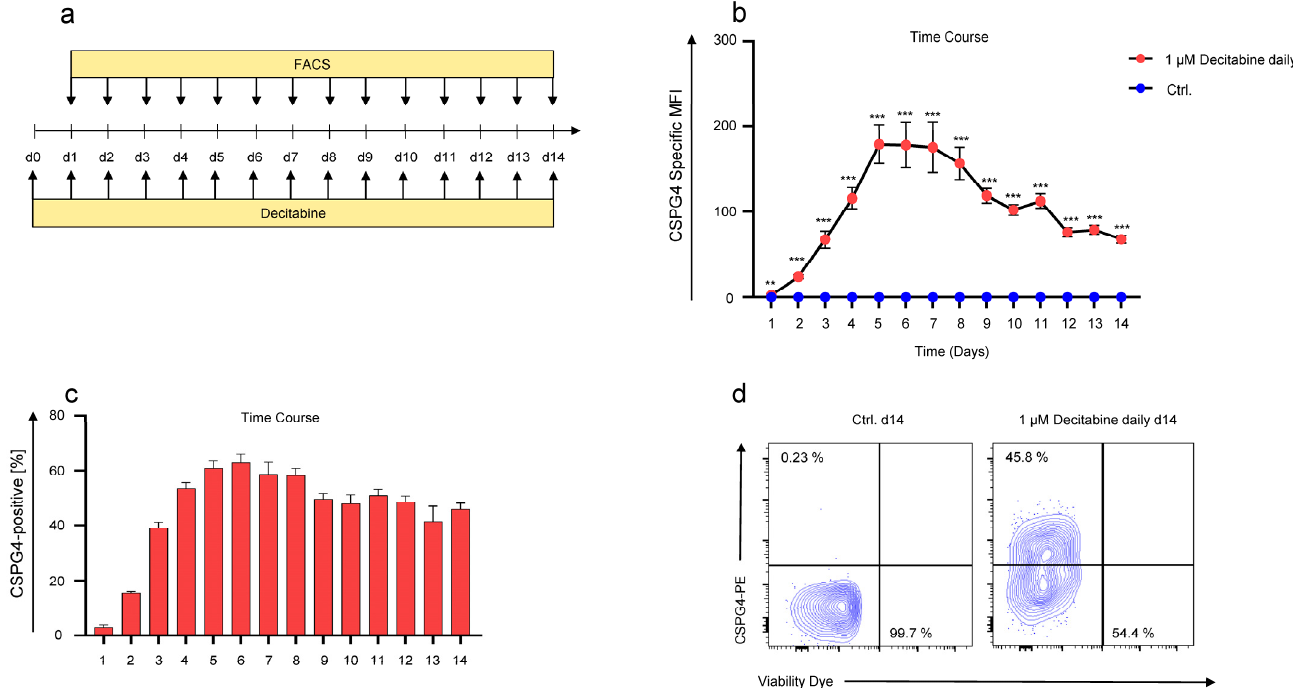
Figure 3. Time course of decitabine-mediated upregulation in SKOV-3 ovarian cancer cells. ( a ) Schematic showing the experimental layout for the time course experiment. SKOV-3 cells were treated daily with 1 µM of decitabine. CSPG4 staining was executed daily for 14 days. Control (Ctrl.) SKOV-3 cells were treated in the same way except for PBS addition instead of decitabine. ( b ) Data represent geometric means ± SEM of three runs, p values were calculated by Student’s t -test, ** indicates p ≤ 0.01 and *** indicates p ≤ 0.001. ( c ) Bar graph showing percentage of CSPG4-positive cells over time. Data represent geometric means ± SEM of three runs. ( d ) Contour plots showing CSPG4 staining on day 14 of SKOV-3 cells treated with PBS (Ctrl.) or 1 µM of decitabine daily. One representative experiment out of three runs.